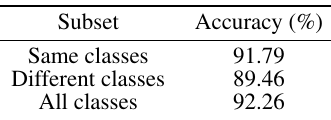
Table 3. Classification accuracies/F1-measures (%) on 20% of the images from the target datasets obtained by training softmax classifiers on the features extracted using the pre-trained networks. The best result for each target dataset is given in bold, and the second best is underlined.